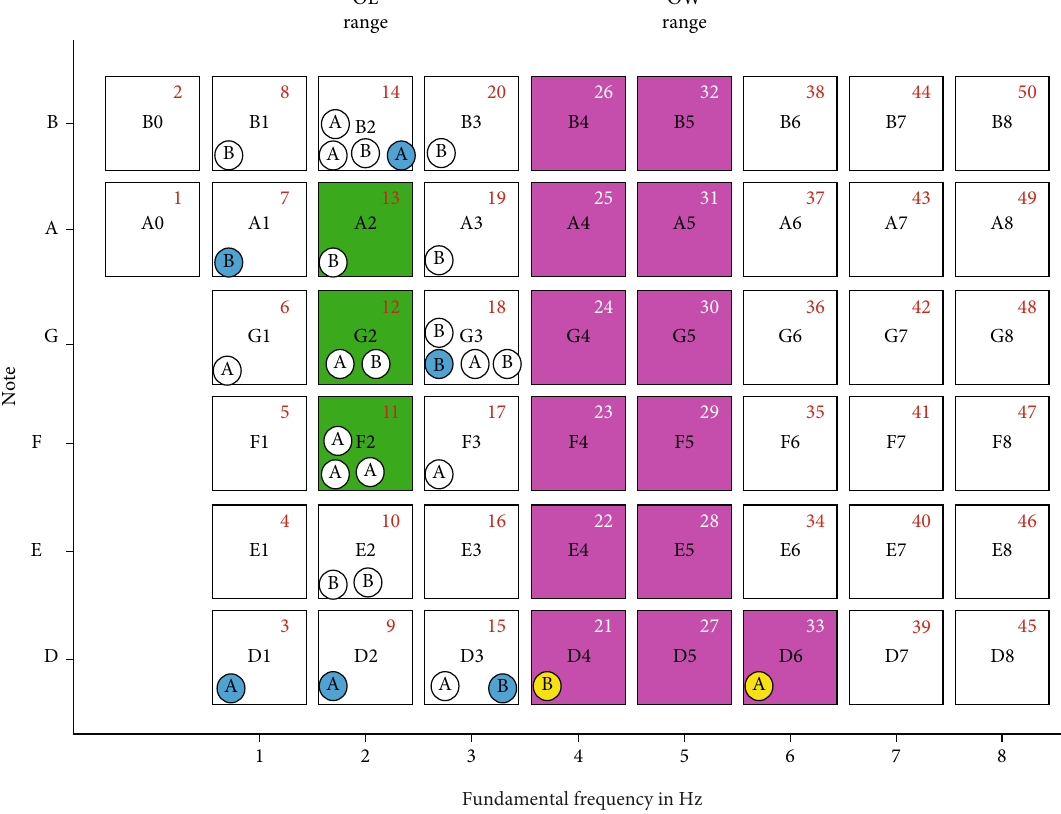
Figure 8: WE-HH. The balloons with the letter (A) represent mean results before the fatigue test, balloons with letter (B) represent mean results after the fatigue test, and the colors indicate the degree of signi fi cance; white balloons are not signi fi